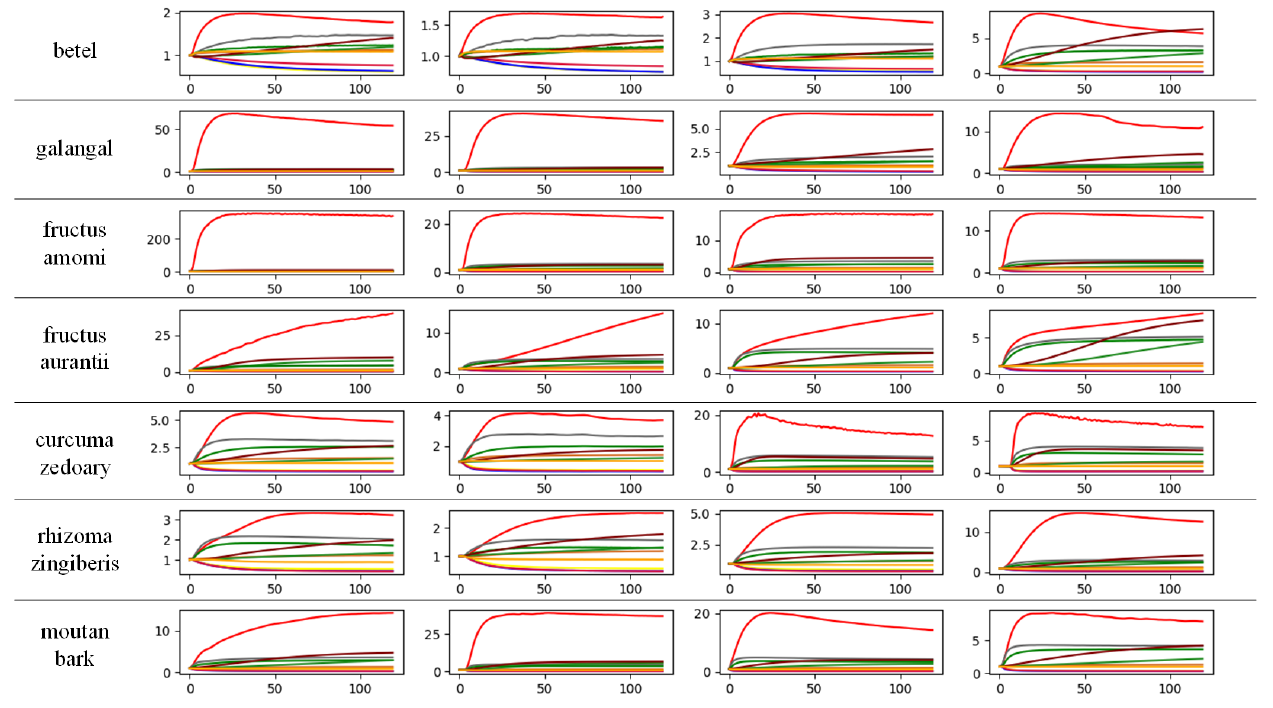
Figure 5. Part of Chinese herbal medicines dataset.